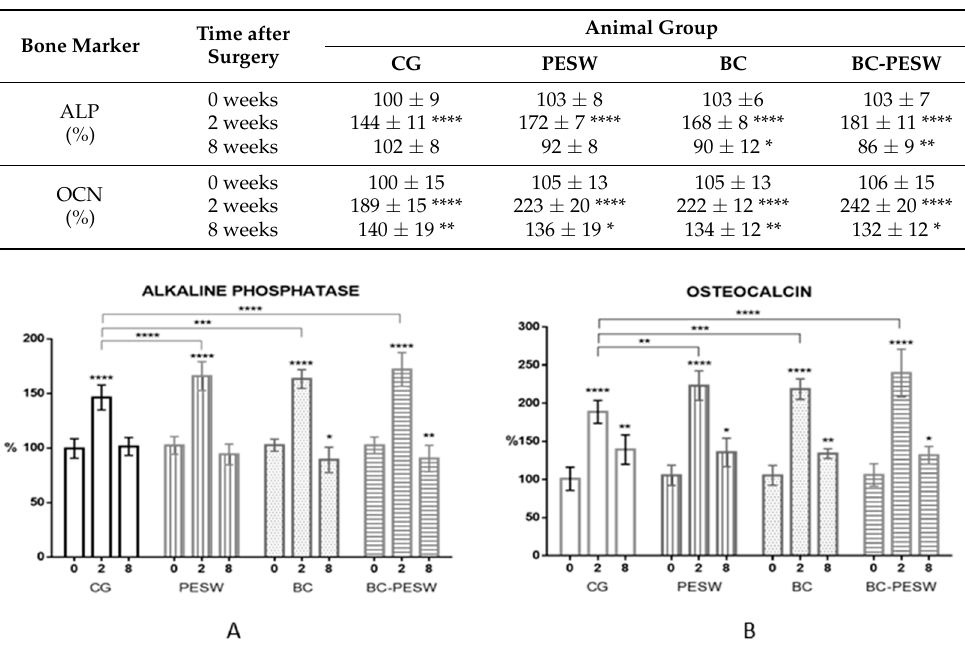
Table 1. Bone marker serum concentration assessment: initial (0 weeks) and two and eight weeks post operation; * statistically significant with p < 0.05; ** statistically significant with p < 0.01; **** statistically significant with p < 0.0001 compared with the initial values (0 weeks) of the group; comparisons were performed within the same group relative to the initial value (0 weeks); alkaline phosphatase (ALP), osteocalcin (OCN).